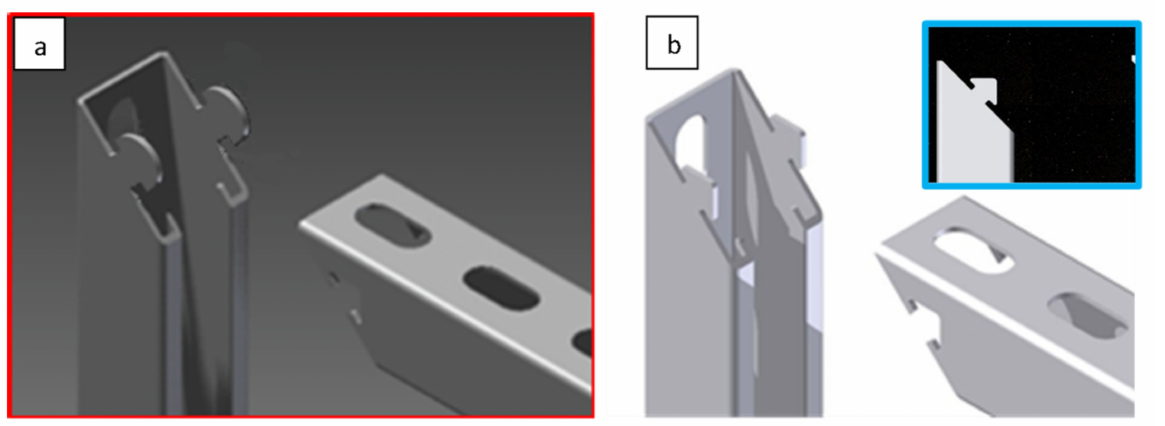
Figure 14. The 3D models of two different lock variants: semicircular ( a ); triangular (arrow) ( b ).